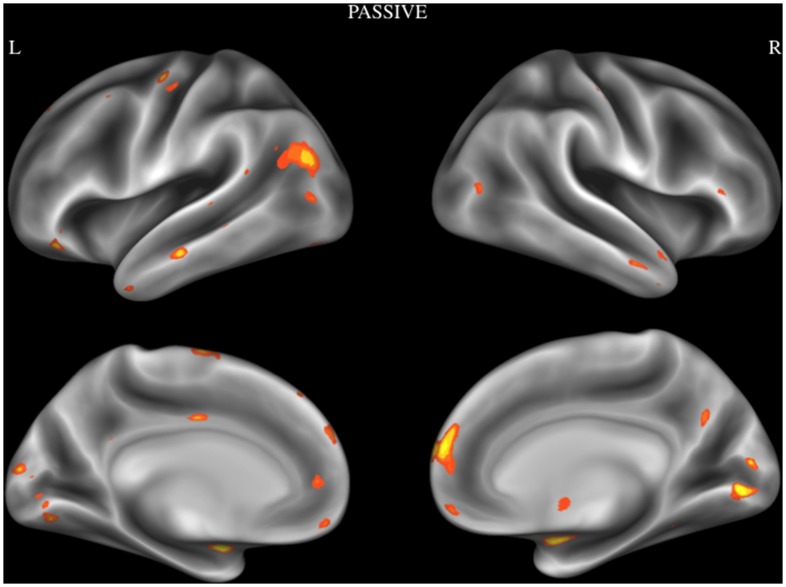
Activation likelihood estimation map showing significant convergent activity for studies in the passive category.Surface maps of the activation likelihood clusters (false discovery rate P<.05) are shown on an inflated surface map in Caret [60].